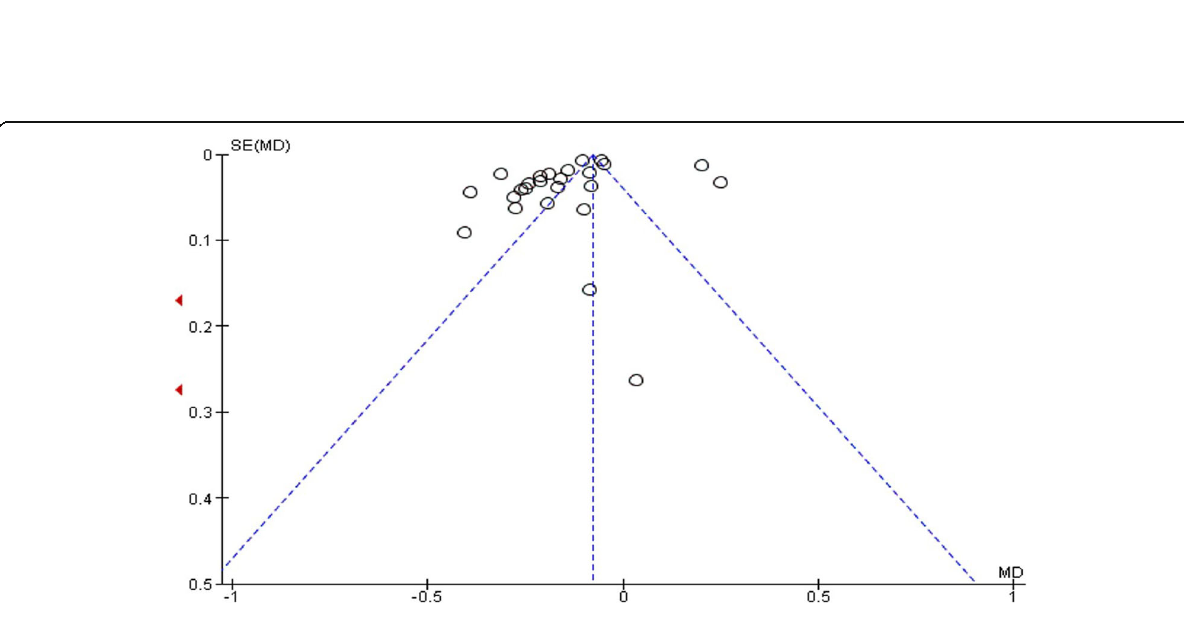
Fig. 4 Funnel plot of published studies evaluating the unstimulated whole salivary flow rate in patients with Sjögren ’ s Syndrome compared to controls (healthy subjects and patients with non-SS sicca). It shows an important publication bias with an asymmetric article distribution. A funnel plot of standard error versus the unstimulated whole salivary flow difference in means is shown. Visual inspection of the funnel plot (scatter diagram) shows asymmetric article distribution confirmed by an Egger ’ s regression test ( P =0.0001). MD: mean difference; SE: Standard